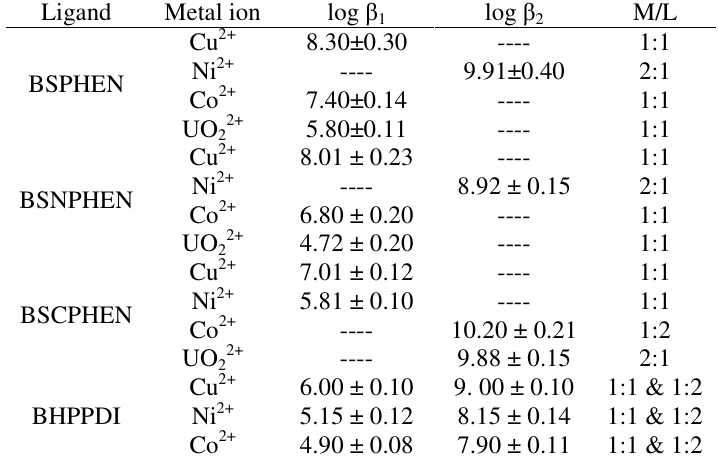
Table 3. The overall stability constants of complexation between some metal ions with BSPHEN, BSNPHEN, BSCPHEN and BHPPDI at 25 ˚C and 0.05 M TEAP in acetonitrile